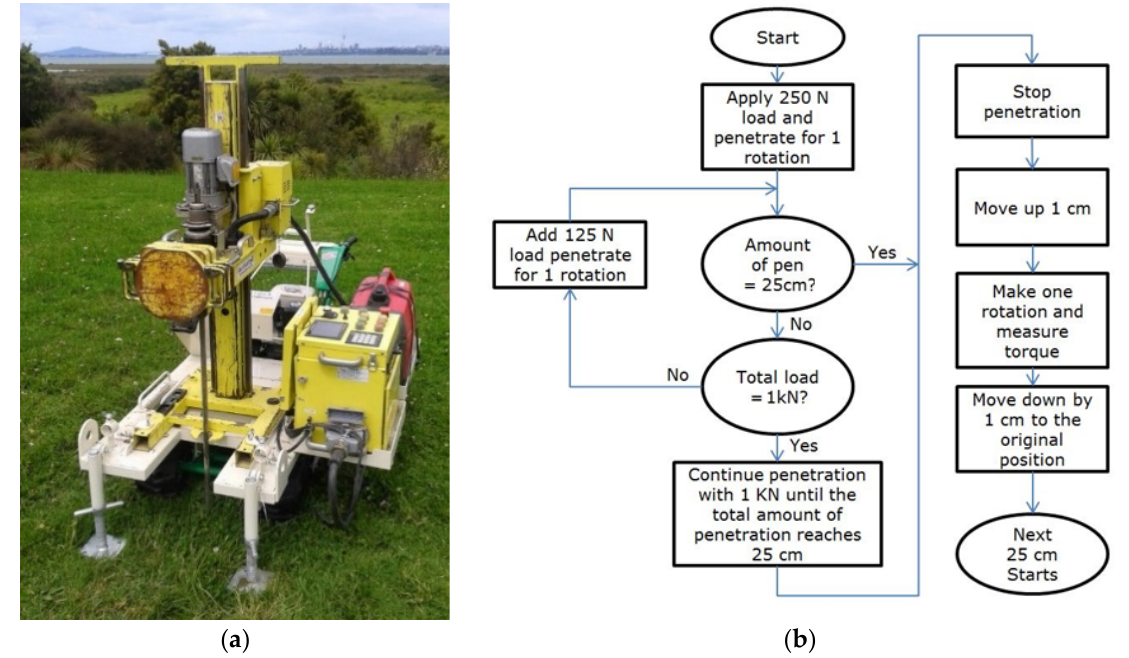
Figure 1. ( a ) View of the SDS machine, and ( b ) the procedure of the SDS test.